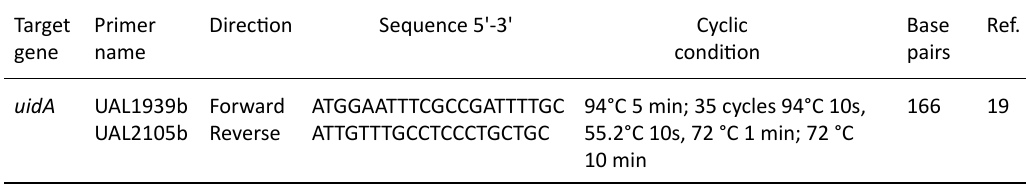
table 1. Details of PCR primer and condition used for the detection of uidA gene in E. coli Target Primer